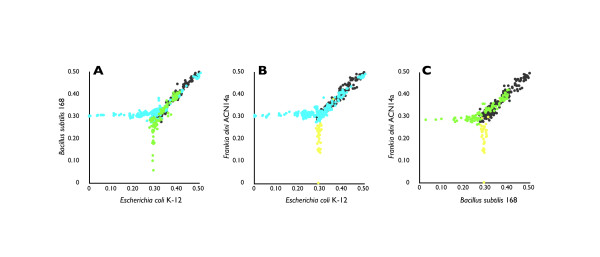
The phylogenetic distance of XerCD in each organism. The phylogenetic distances of bacterial genomes to three seed organisms, Escherichia coli (Proteobacteria), Bacillus subtilis (Firmicutes) and Frankia alni (Actinobacteria), were calculated as the average of phylogenetic distances of XerC and XerD. Detailed example is given in Additional file 1, Figure S1. A to C are scatter plots of the distances of these genomes to the seed organisms. Axes represent average distances as calculated by ClustalW. A, Distances from Escherichia coli K-12 and Bacillus subtilis 168; B, distance from Escherichia coli K-12 and Frankia alni ACN14a; and C, distance from Bacillus subtilis 168 and Frankia alni ACN14a. Blue represent the genomes of Proteobacteria, green represent Firmicutes, yellow represent Actinobacteria, and the gray marks represent other phyla. All phyla show strong preferences for seeds from the same phylum.